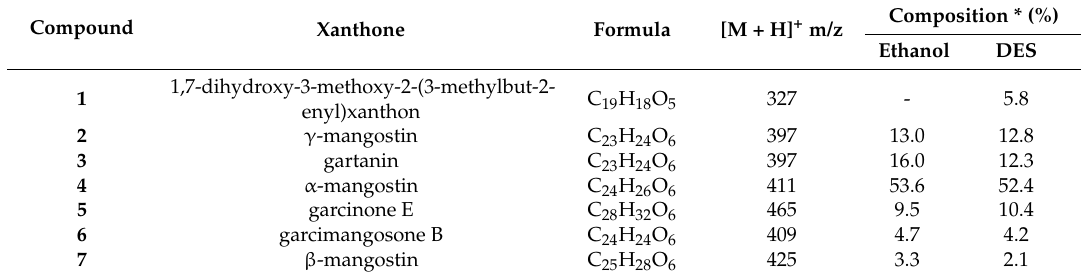
* Composition estimates based on the normalized area of HPLC